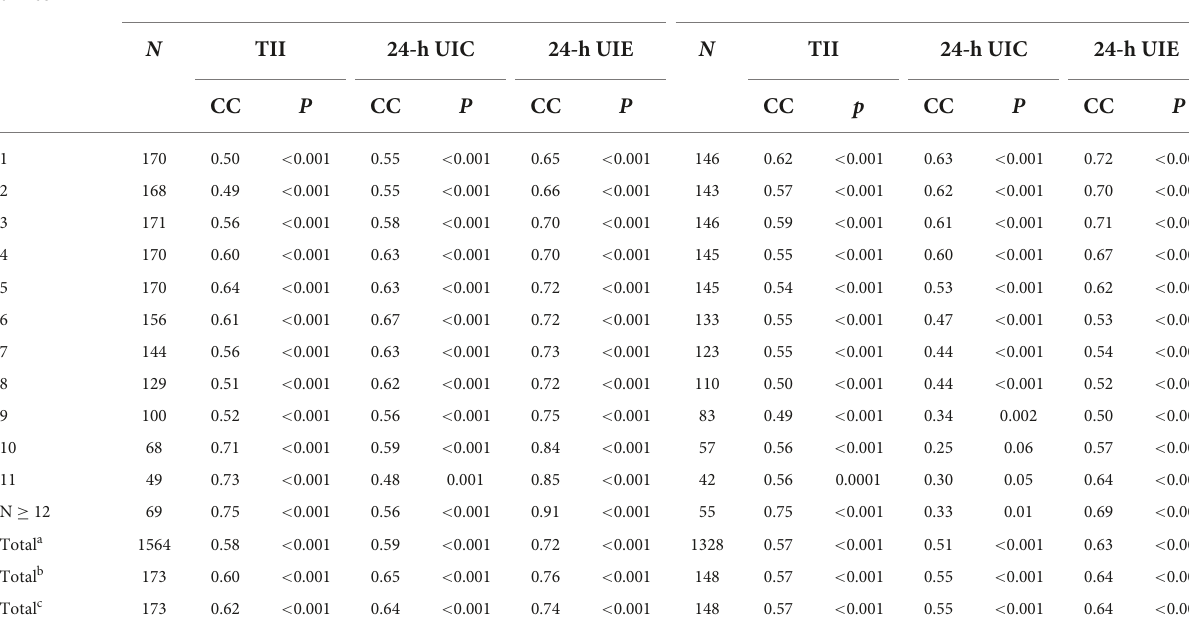
TABLE 3 Correlations between breast milk iodine concentration (BMIC) and total iodine intake (TII), urinary iodine excretion (UIE) and urinary iodine concentration (UIC) on the same day and the prior day. BMIC collection